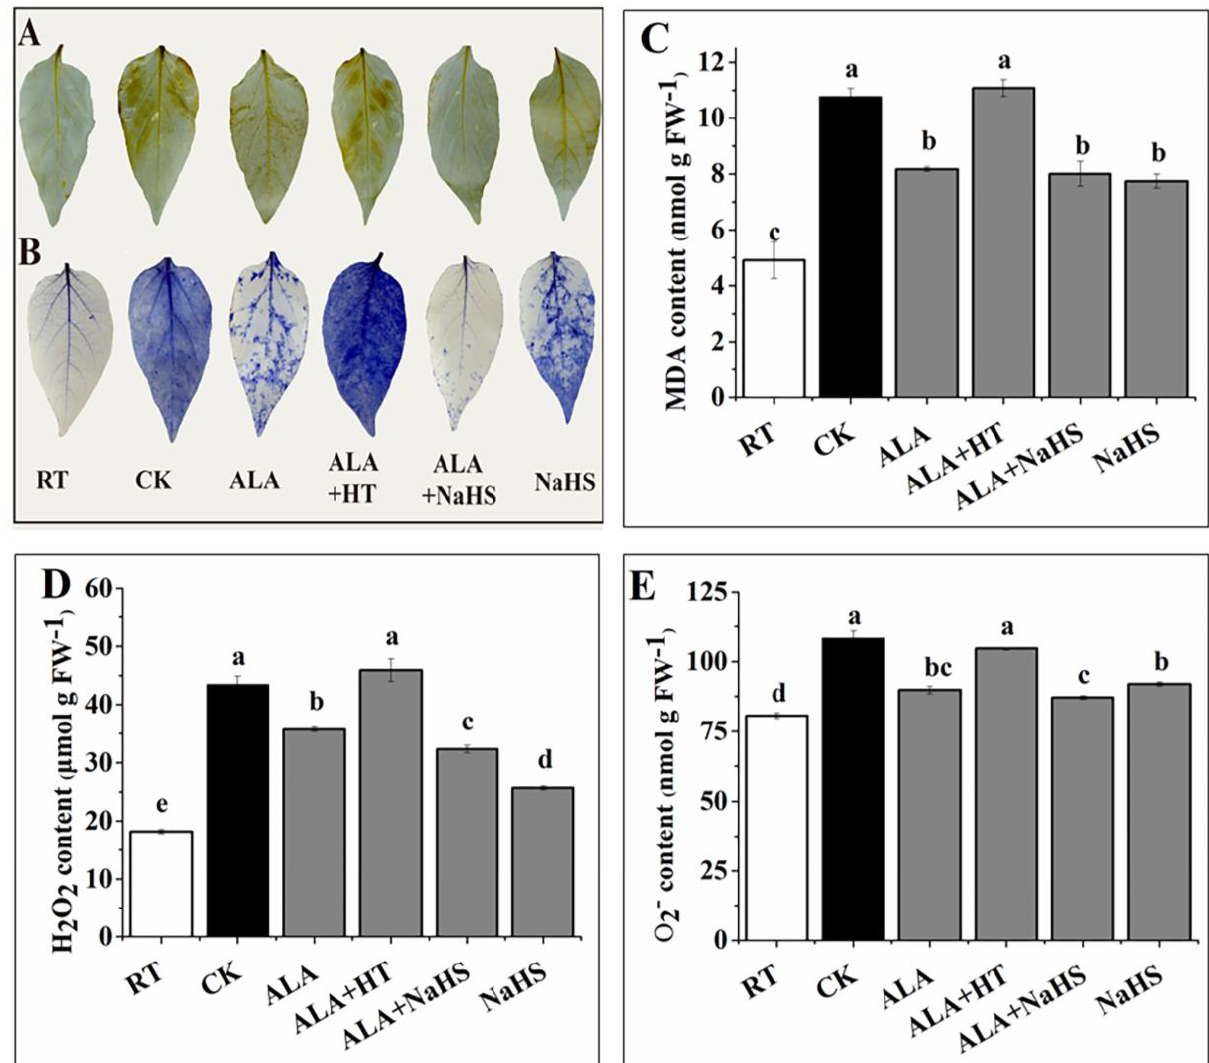
Figure 2. Effects of ALA and/or H 2 S on DAB staining ( A ), NBT staining ( B ), the contents of MDA ( C ), H 2 O 2 ( D ), and O 2 •− ( E ) under chilling stress for 24 h. The error bars are the standard errors for three independent tests. Different letters show significant differences ( p < 0.05) based on Duncan’s test.